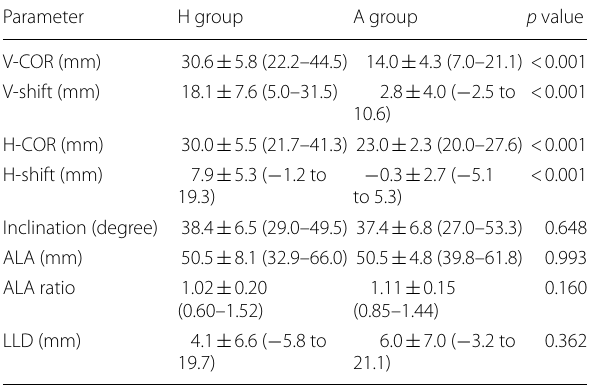
Table 3 Postoperative radiographic measurements